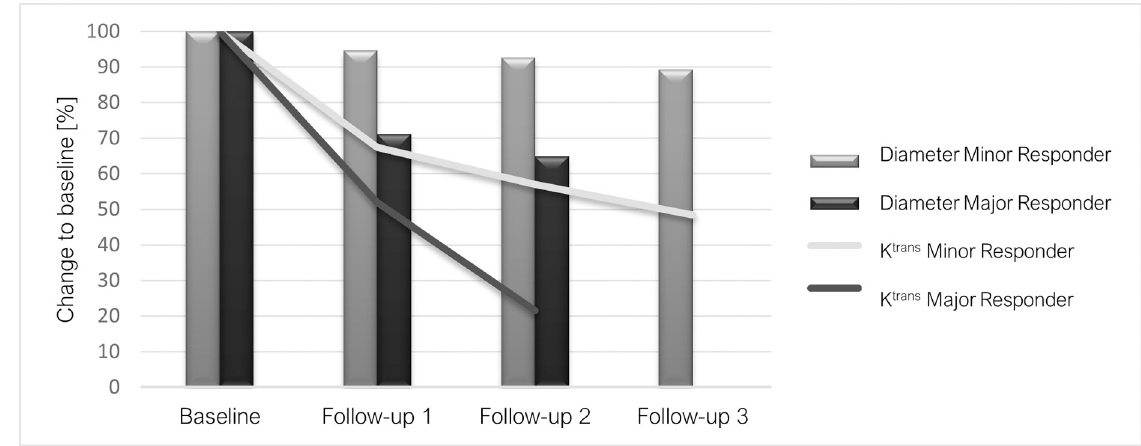
Fig 4. Percentual change of K trans and tumor size in minor and major responders during therapy with Erlotinib and Bevacizumab.